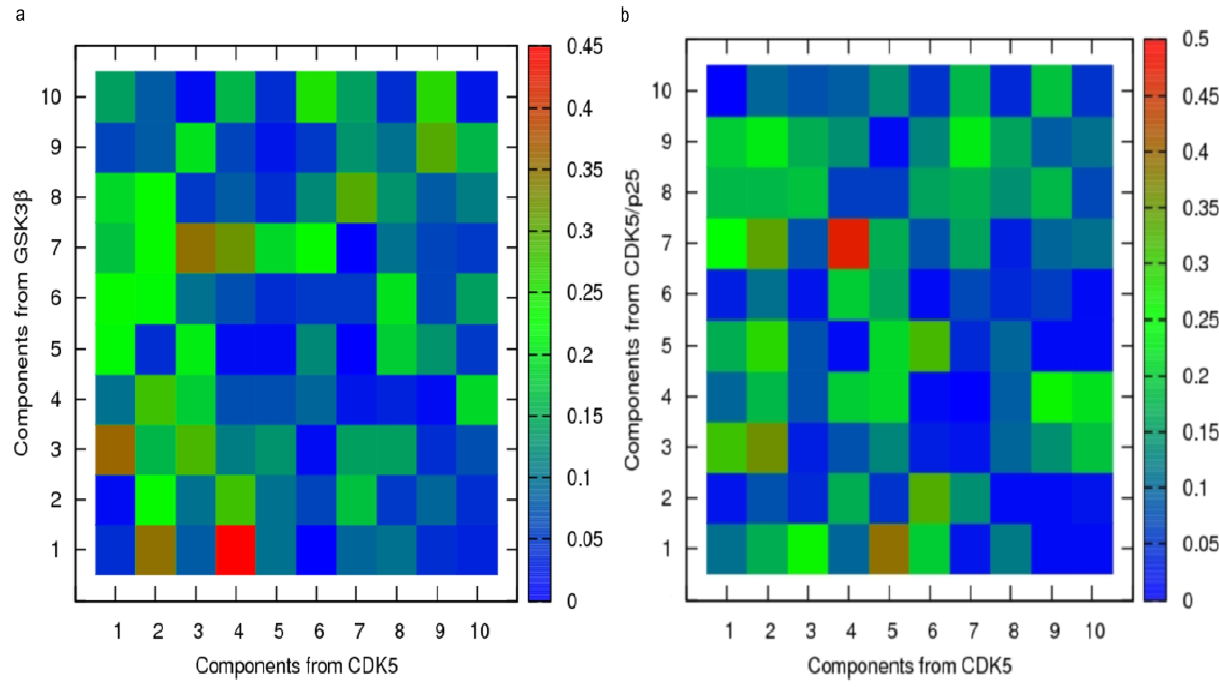
Figure 9. Inner product comparisons for the top ten ranking eigenvectors from simulations of ( a ) CDK5 and GSK3 β ; ( b ) CDK5 and CDK5/p25. Red squares signify a high level of similarity between two vectors, green for an intermediate level and blue for poor or no similarity.